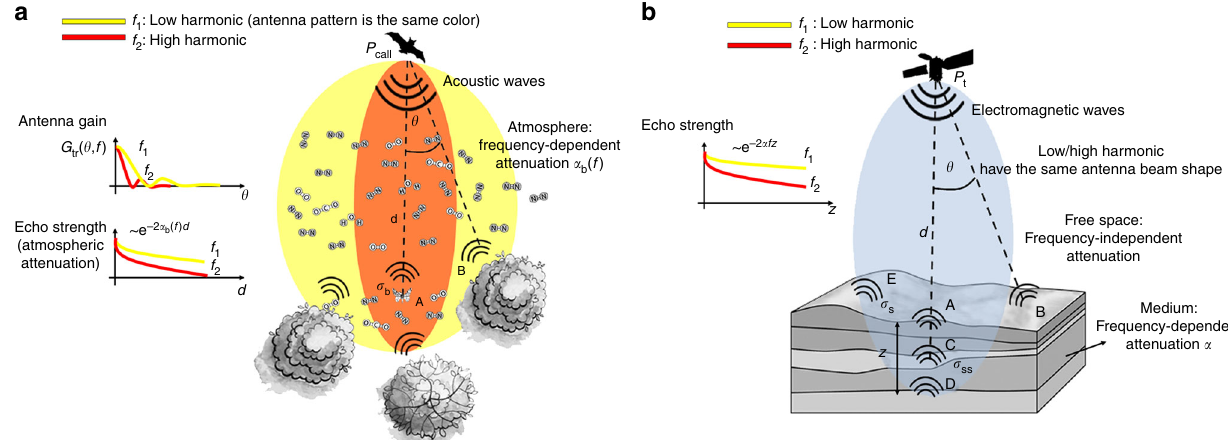
Fig. 4 Bats and radar sounder acquisition geometry scheme. a Visualization of bats acquisition geometry assuming multi-harmonic signal transmission. The bats exploits a combination of atmospheric attenuation and antenna pattern diversity to distinguish clutter echoes coming from foliage. b Acquisition geometry for radar sounders assuming multi-harmonic transmission. The echo strength reduction in the subsurface depends on the transmitted